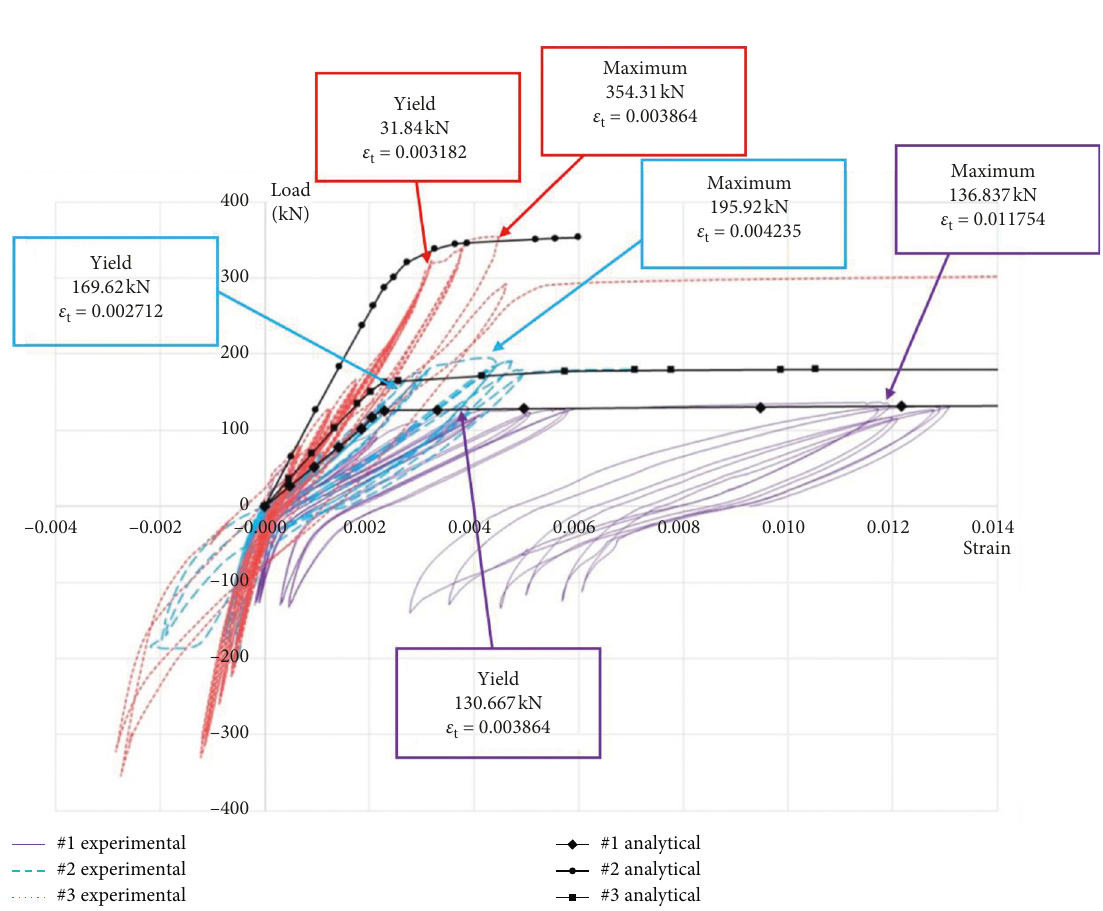
Figure 6: Comparison of analytical load-strain relationships with test data from Strain Gauge #20 [17,